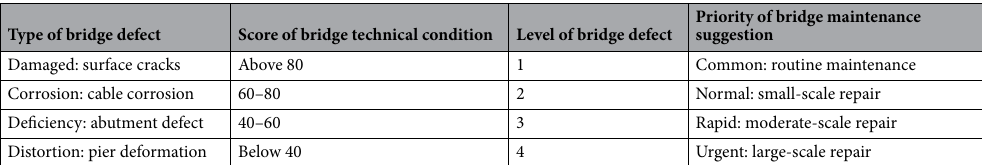
Table 4. Priority maintenance suggestions for bridge